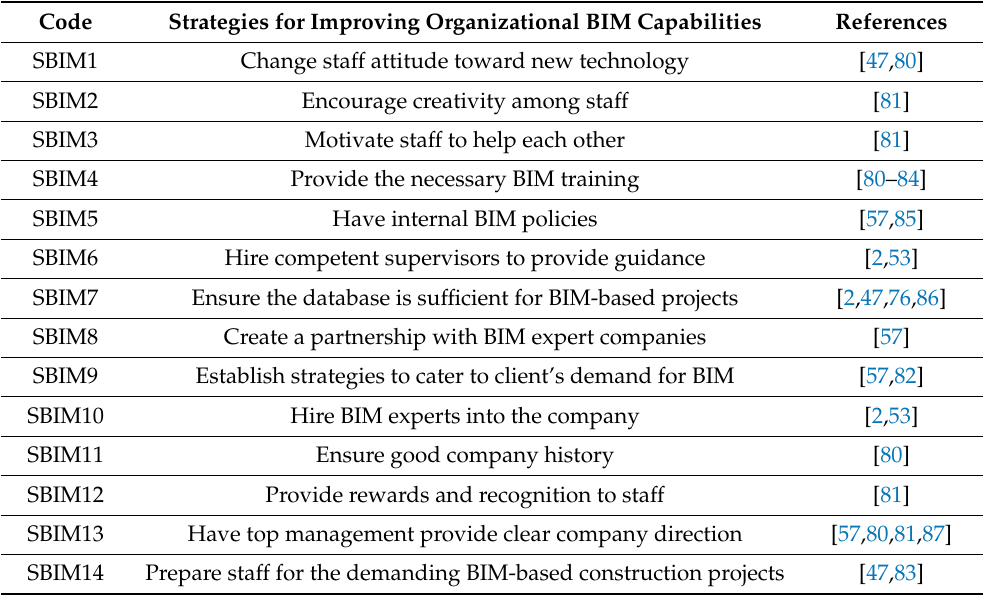
Table 1. List of strategies for enhancing OBIMC.